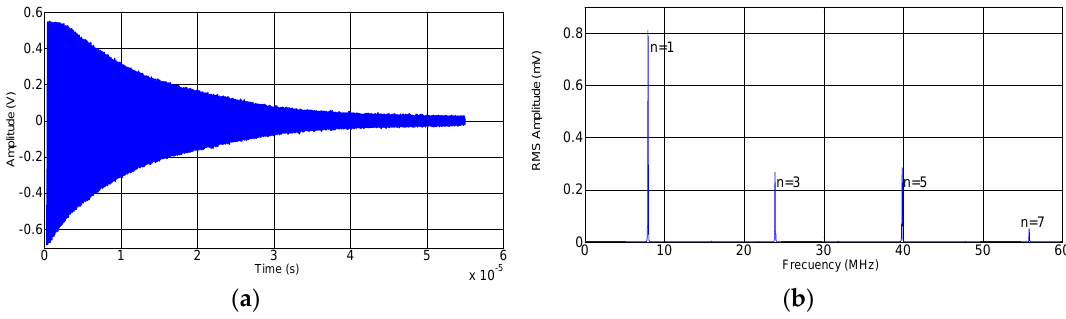
Figure 3. ( a ) Time trace of the signal on the oscilloscope; and ( b ) frequency spectrum derived from the time trace by Fourier transformation.